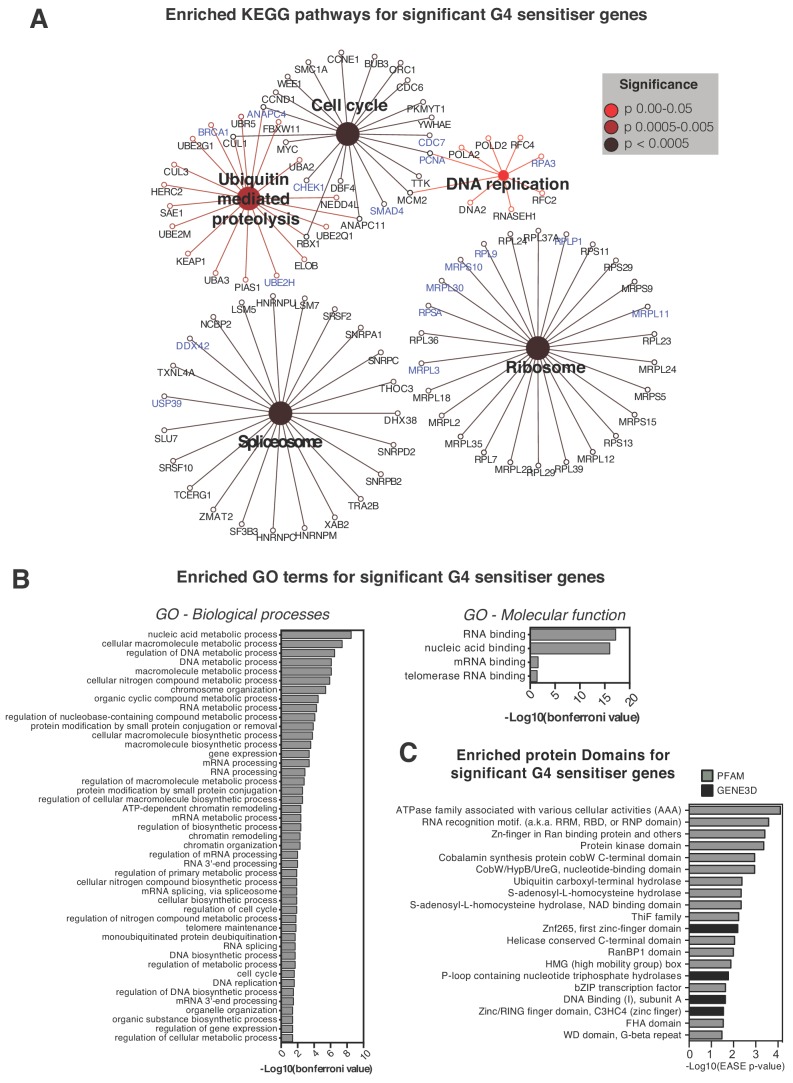
Pathways and processes showing sensitivity to G4-stabilising ligands.(A) Enriched KEGG pathways and (B) Gene Ontology terms, GO Biological Processes (BP) and Molecular Functions (MF), for the 758 genome-wide G4-sensitiser genes. Blue- genes common to both ligands; black- genes unique to either PDS or PhenDC3. A right-sided enrichment test with Bonferroni correction used (see Materials and methods). (C) Enriched protein domains (p≤0.05) within GENE3D (black) and PFAM databases (grey) ordered by -Log10 (EASE p-value). See also Supplementary file 1.